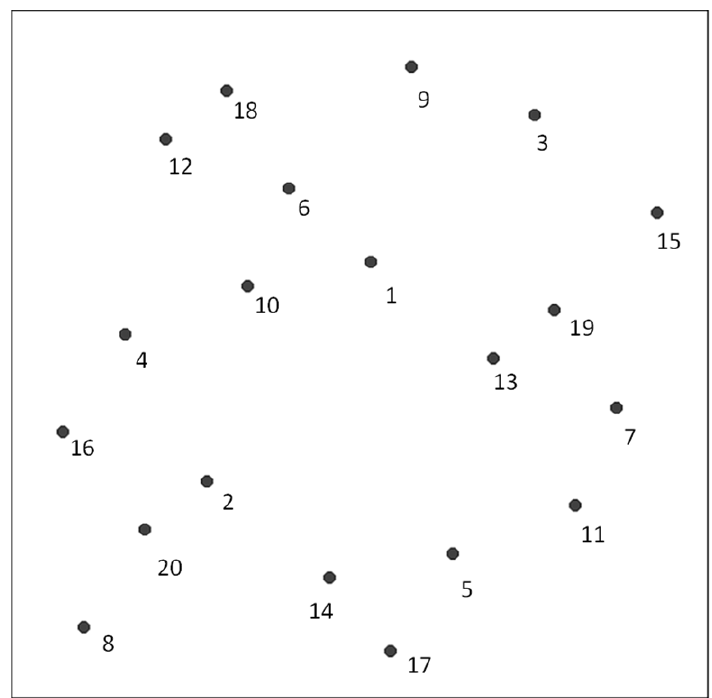
Figure 8. Network topology for research. The emission power was 20 dBm, and the minimum receiver sensitivity was 65 dBm. Messages were generated for 1000 s, and the size of each message was 500 bytes. Average duration of message processing by one node was 1 s. transmitted for a network of 20 nodes, respectively.